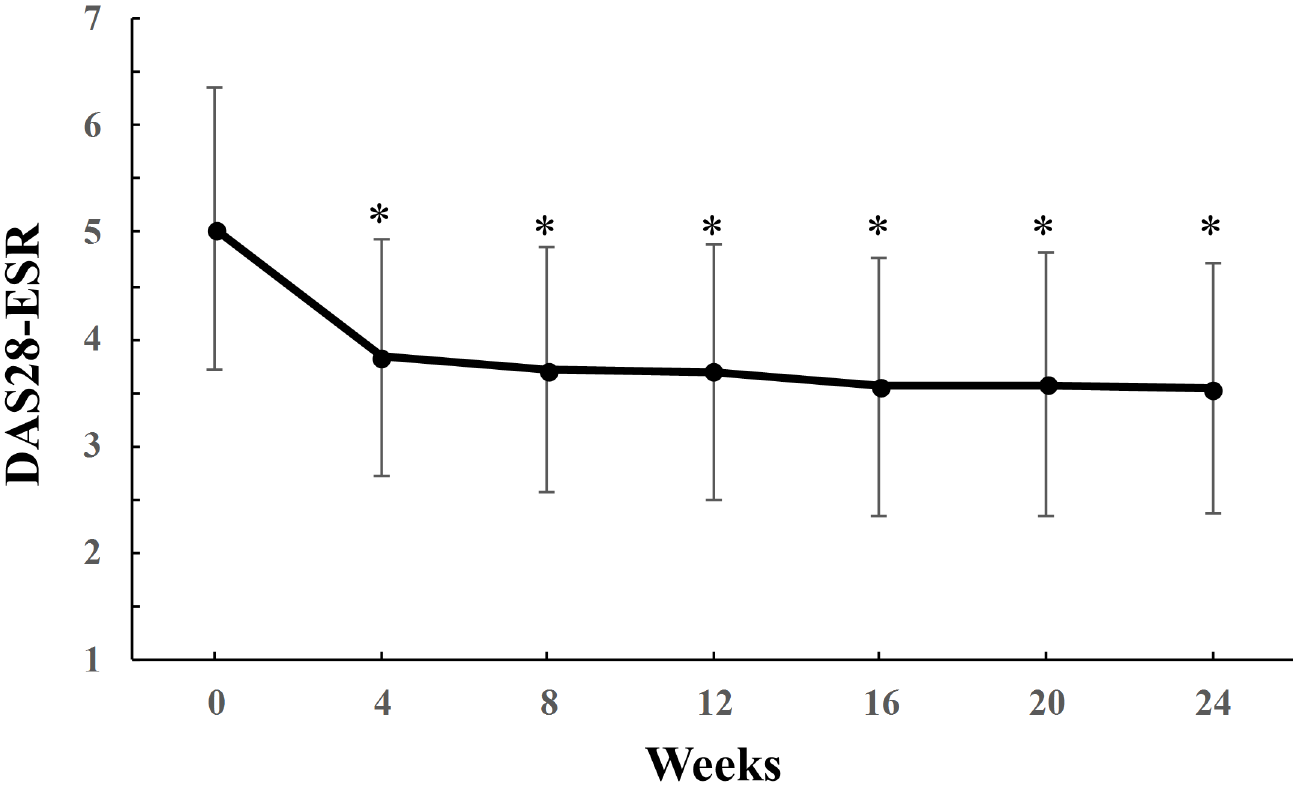
Fig 1. Time course of disease activity scores over 24 weeks of tofacitinib treatment. Data were analyzedby the LOCF method. Points and bars represent means and standarddeviations, respectively. * p < 0.0001 versus baselineby the Wilcoxon signedrank test. LOCF last observation carried forward, ESR erythrocyte sedimentation rate, DAS diseaseactivity